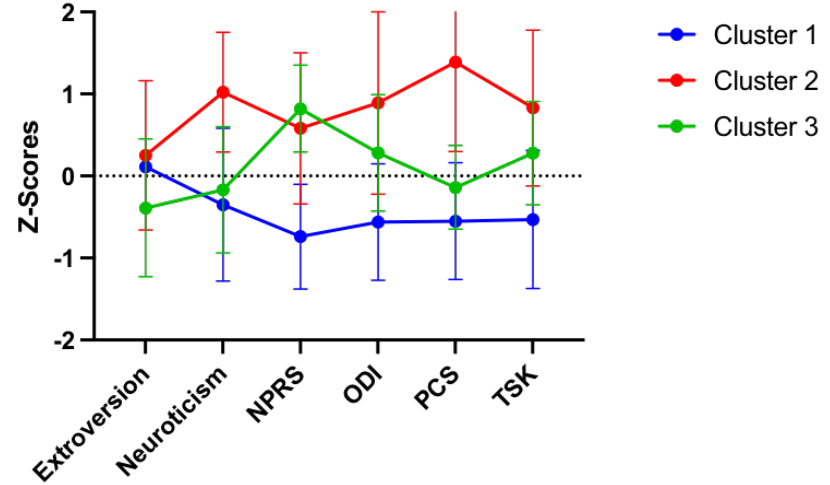
Figure 3. Differences across clusters by personality, clinical factors, and pain-related psychological factors. Table 4. Differences across clusters by demographic